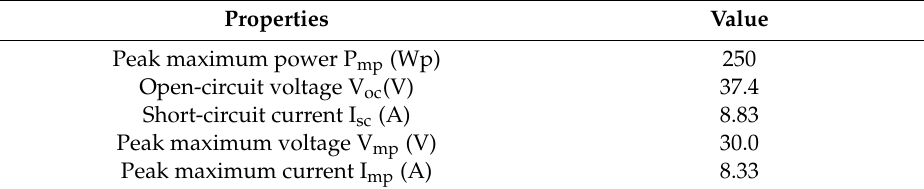
Table 1. PV electrical specification.